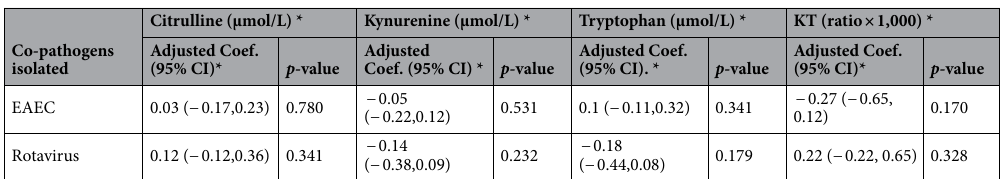
Table 5. Association of citrulline, kynurenine, and tryptophan concentrations and the KT ratio at baseline with isolated pathogens in stool culture. Coef.: coefficient; 95% CI: 95% confidence interval; *Models adjusted for age at enrollment. Values represent the beta coefficient and 95% CI from linear regression models.